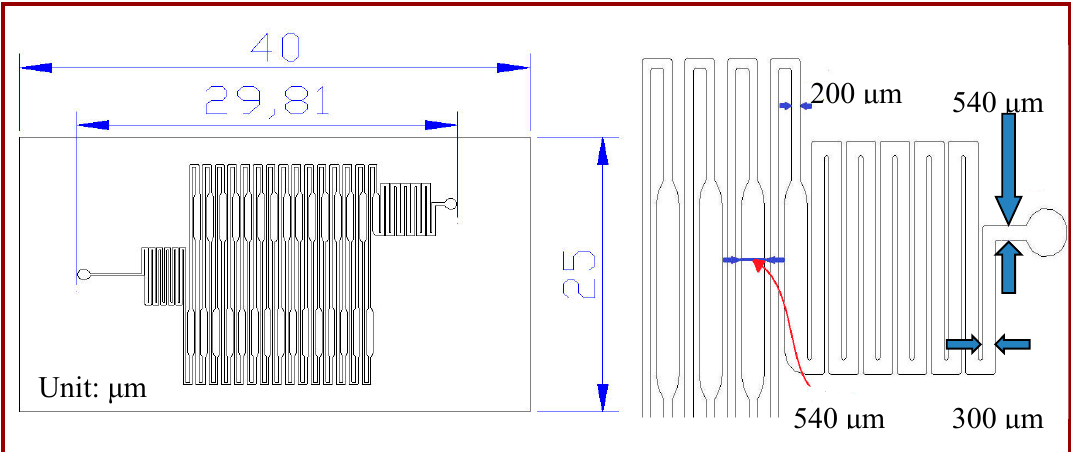
Figure 1. The schematic drawing of the continuous-flow polymerase chain reaction (CFPCR) chip.